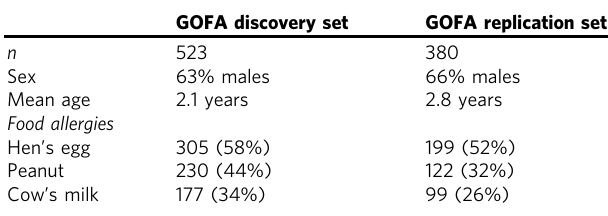
Table 1 Characterization of the German Genetics of